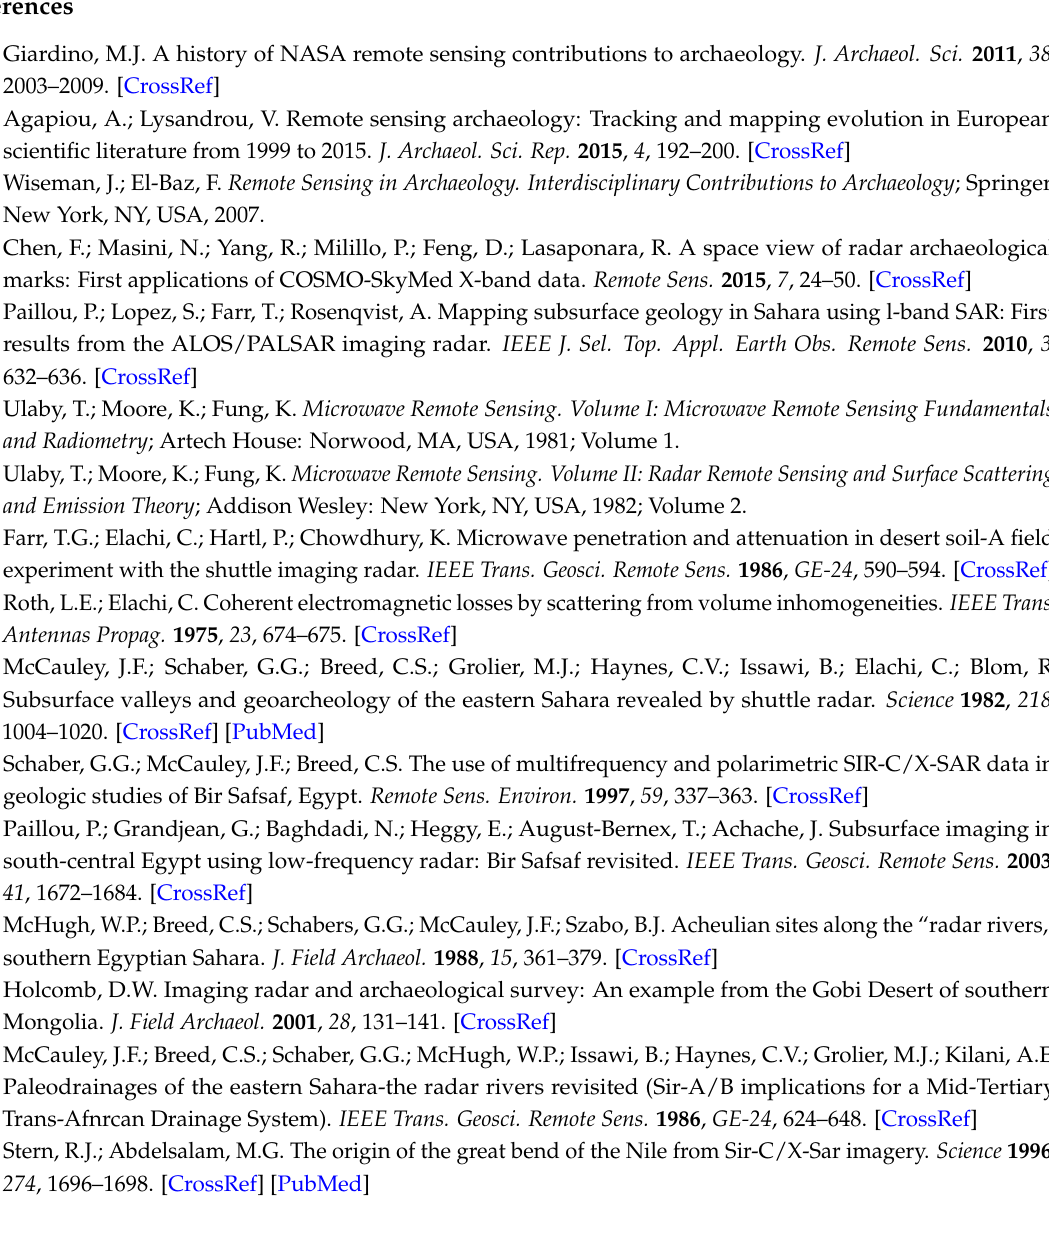
Table S1: PALSAR-1 FBD Scene IDs, Table S2: PALSAR-1 FBS Scene IDs, Table S3: PALSAR-2 Scene